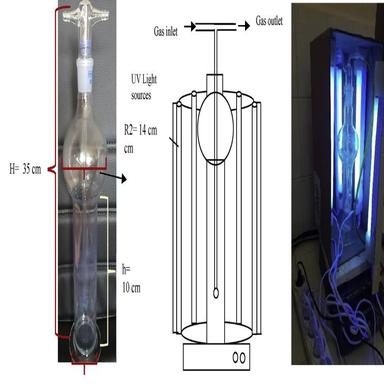
Photocatalytic oxidation process experimental setup.